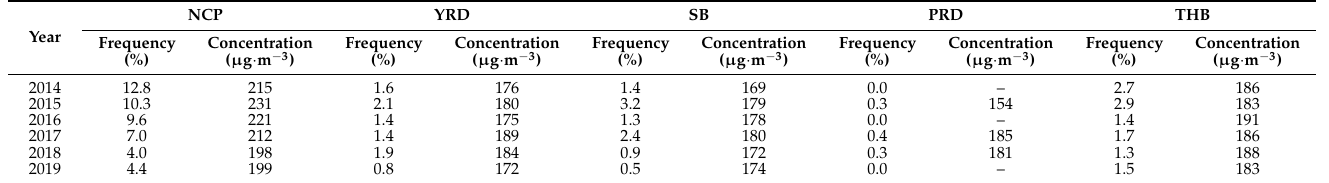
Table 2. Descriptive statistics of heavy pollution events (HPEs) over the NCP, YRD, SB, PRD, and THB during